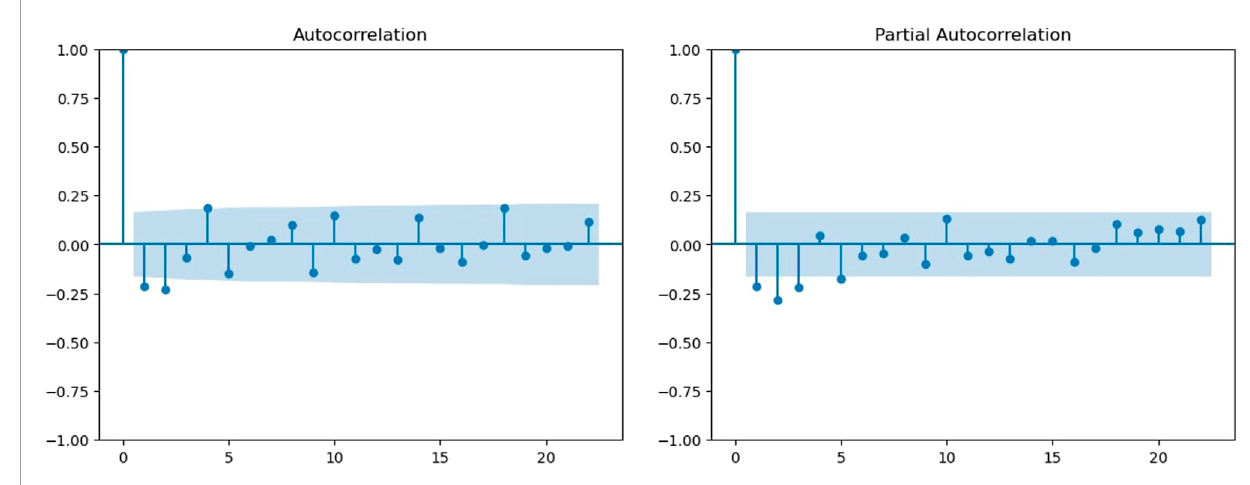
FIGURE 4 ACF and PACF of first differences. (A) ACF of the first difference. (B) PACF of the first difference.